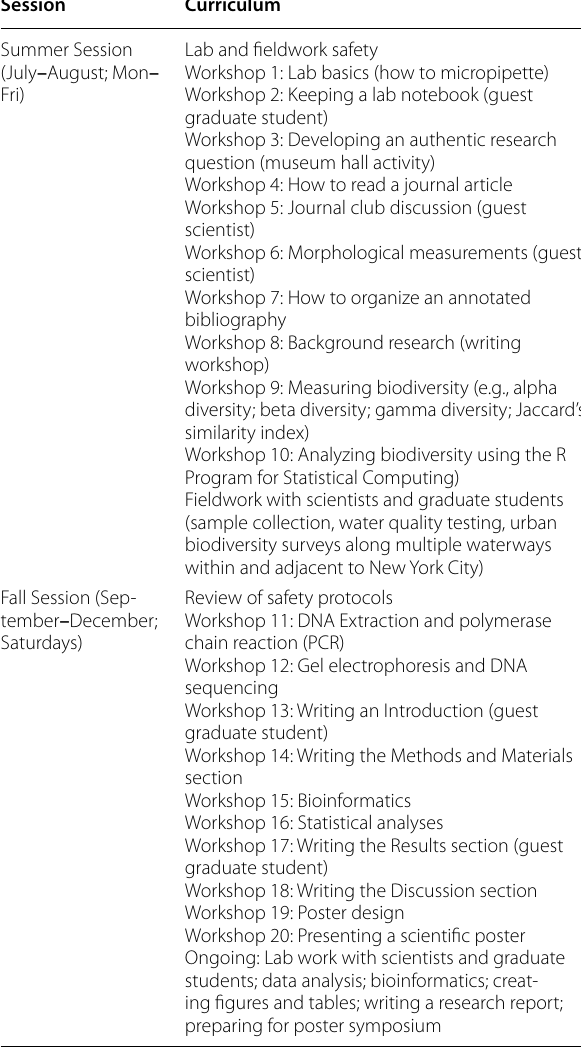
Table 2 Landscape genetics research team curriculum